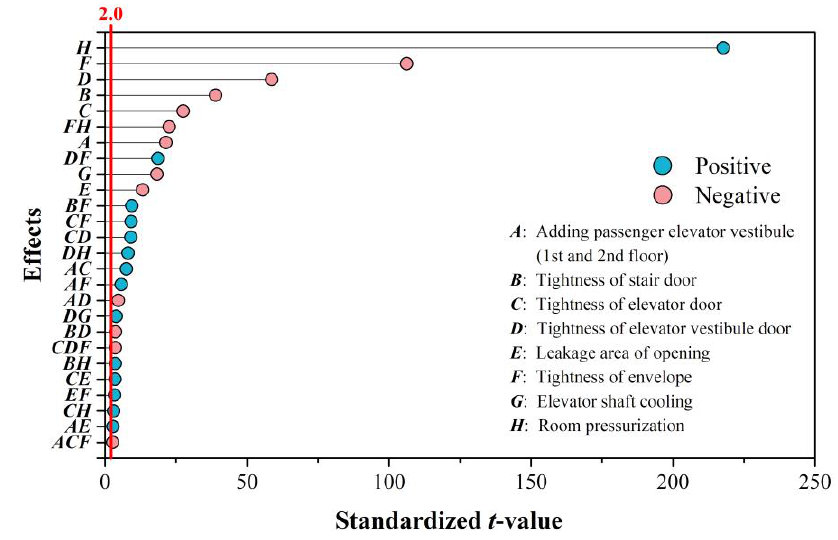
Figure 7. The total infiltration: Pareto effect plot.